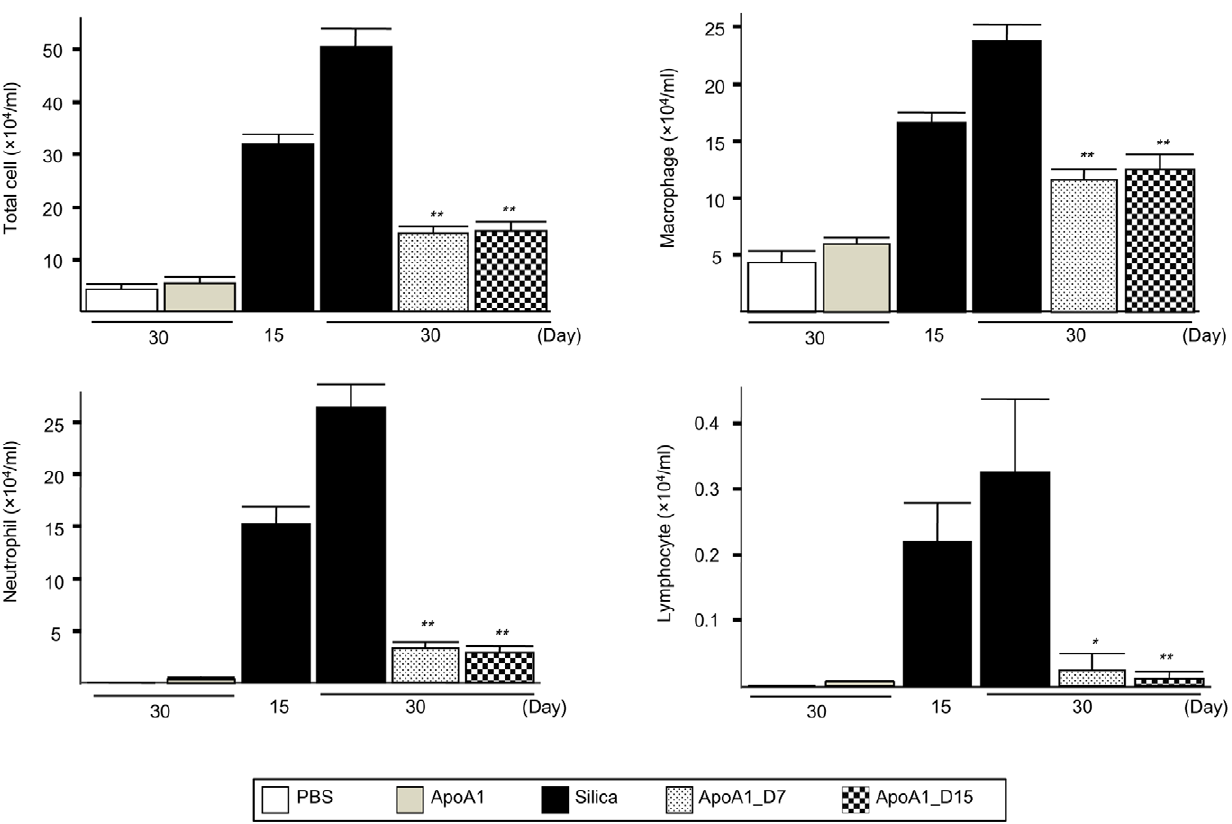
Figure 3. Differential cell counts from the BAL fluid of ApoA1 transgenic mice. ** p , 0.01 compared with the Silica group (D15 and D30).